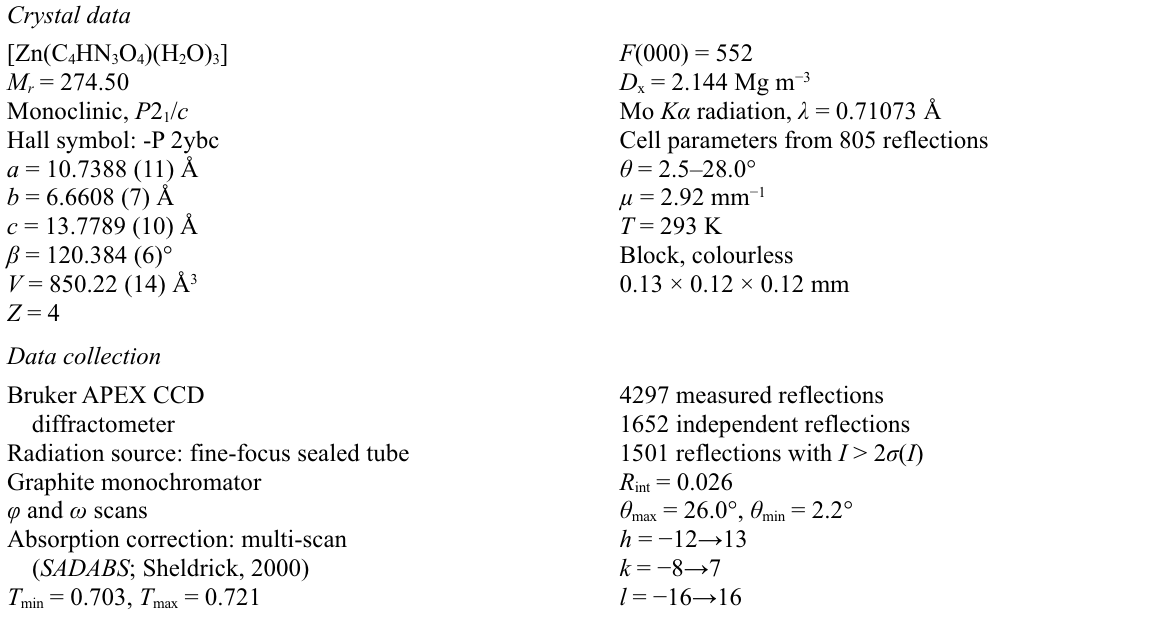
The one-dimensional chain of the title